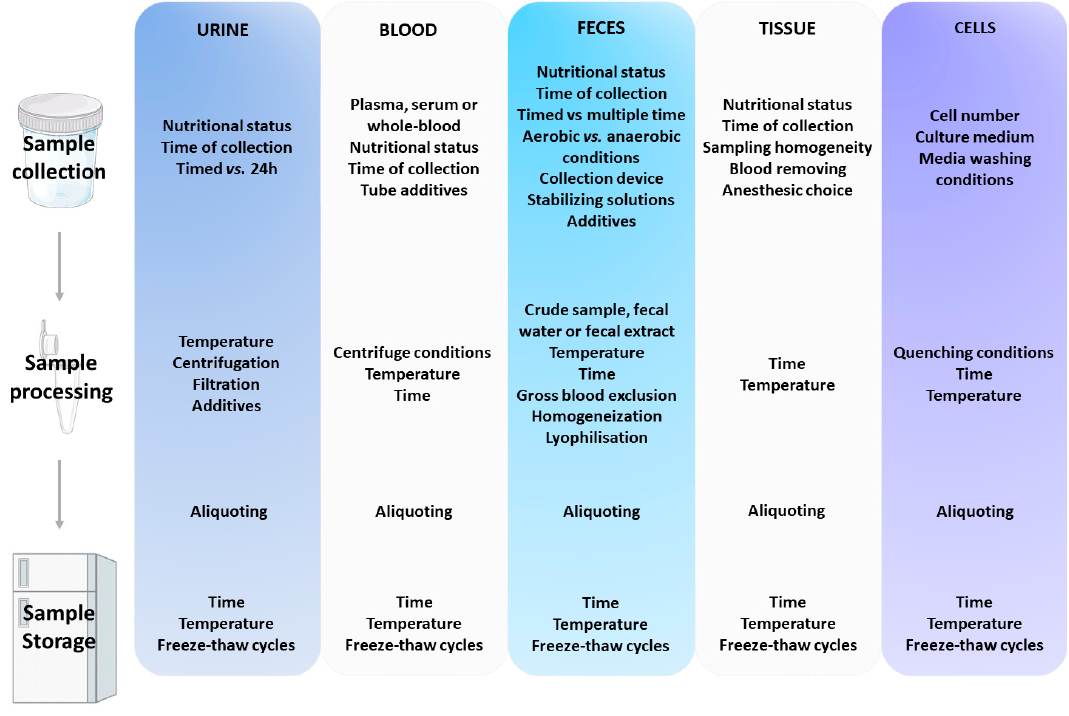
Figure 1. Summary of pre-analytical factors that can affect metabolite profiles in various matrices.